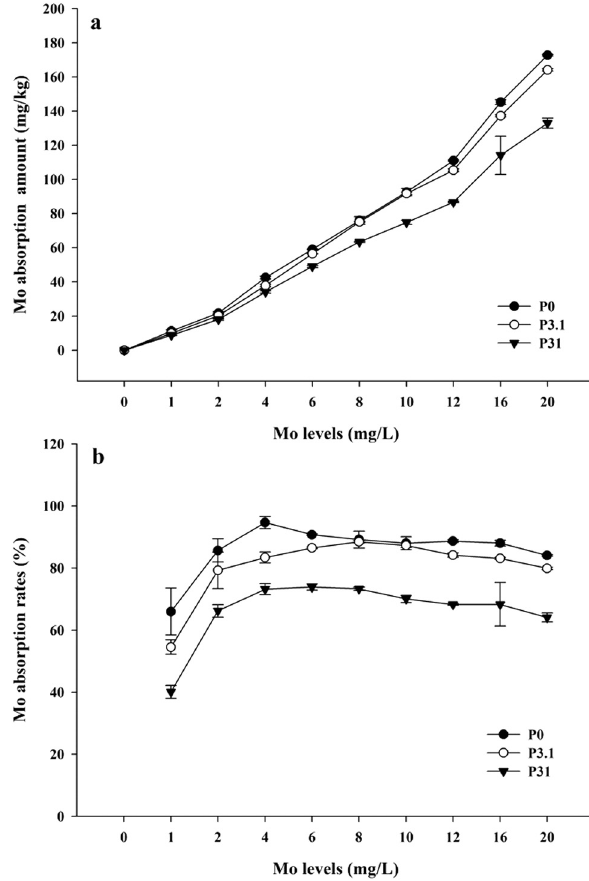
Figure 2: Di ff erences in Mo adsorption isothermal equation between two nonlinear fi tting of three phosphate levels: ( a ) 0 mg P/L, ( b ) 3.1 mg P/L, and ( c ) 31 mg P/L.